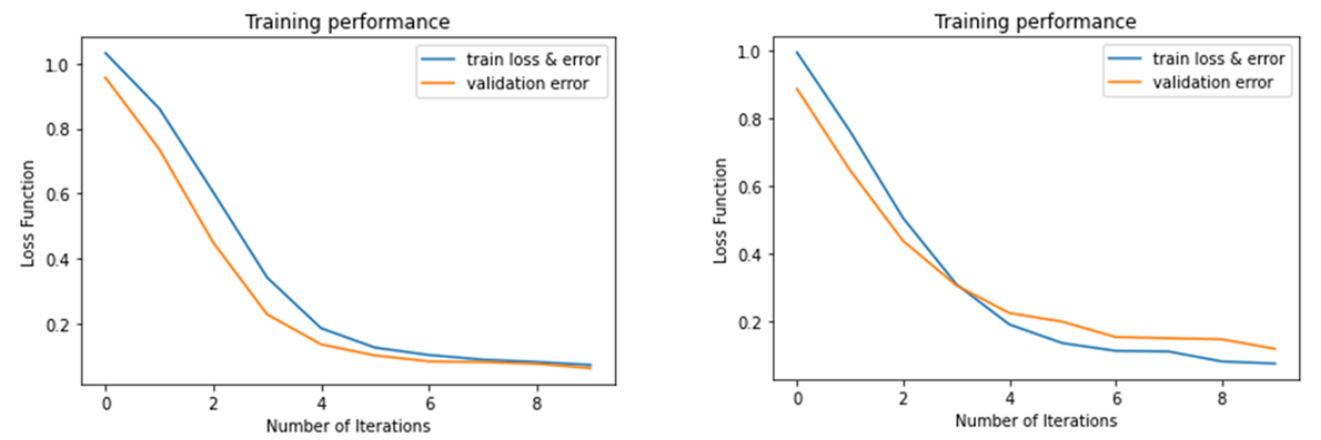
Figure 11. The first subfigure shows the training performance of the respiration dataset, while the second subfigure shows the training performance of the movement dataset. These training performances are based on the number of iterations to loss